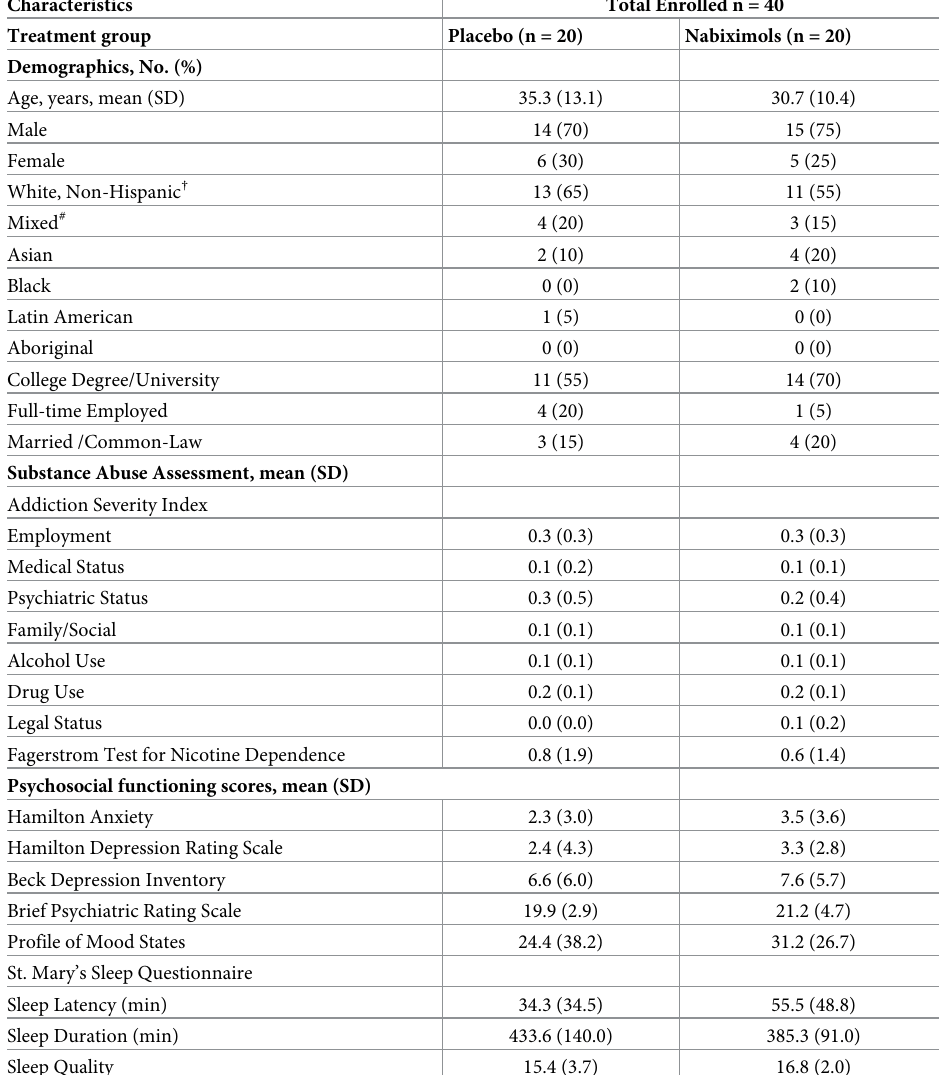
Table 1. Baseline characteristics for treatment groups. Table shows demographics, substance abuse assessments and psychosocial functioning scores. Values represent mean values (SD). Characteristics